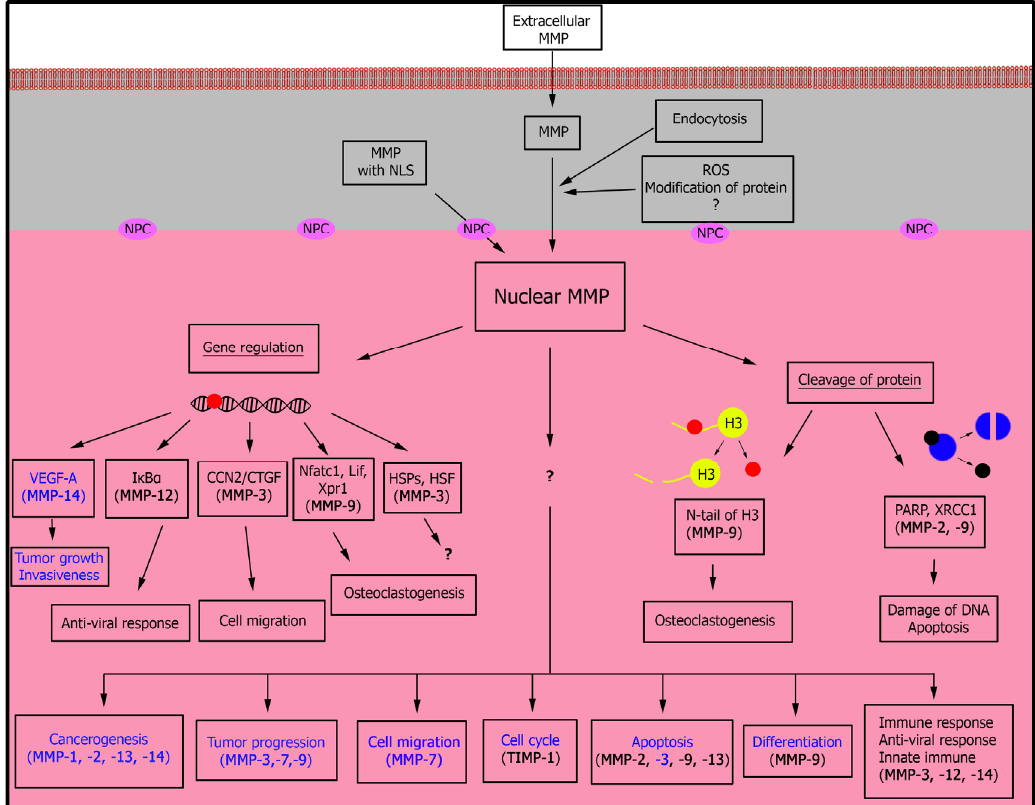
Figure 3. Role of nuclear MMPs within cells. Currently, only two mechanisms for the transport of MMPs into the cell’s nucleus are known, and which utilize the nuclear pore complex or endocytosis. Within the nucleus, MMPs can cleave nuclear proteins or regulate the transcription of various genes. Through these mechanisms, nMMPs can modulate a number of key biological processes within the cell. Participation of nMMPs in cancer cell progression is indicated in blue. NPC—nuclear pore complex; MMP—matrix metalloproteinase; NLS—nuclear localization signal.